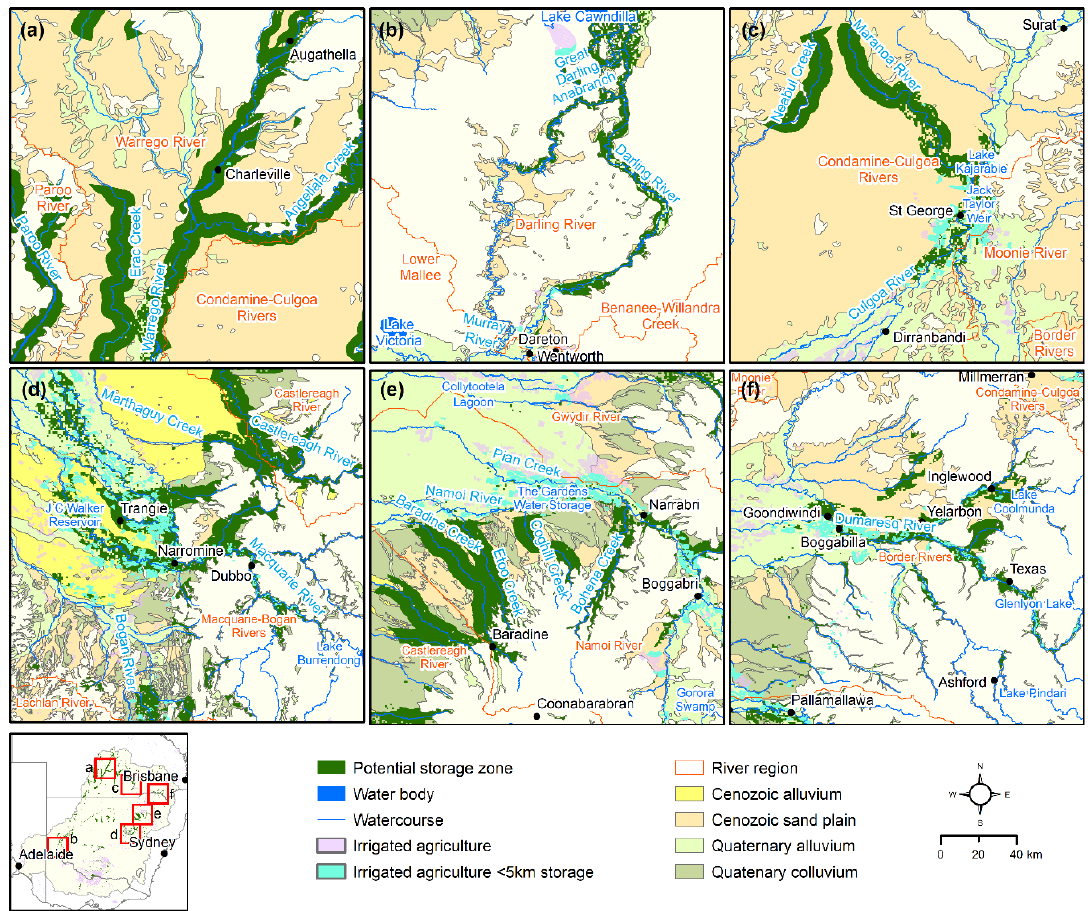
Figure 5. Examples of regions with different classes of aquifer storage to irrigated area potential: >3 m ( a , b ); 0.3 to 0.7 m ( c , d ); < 0.3 m ( e , f ).